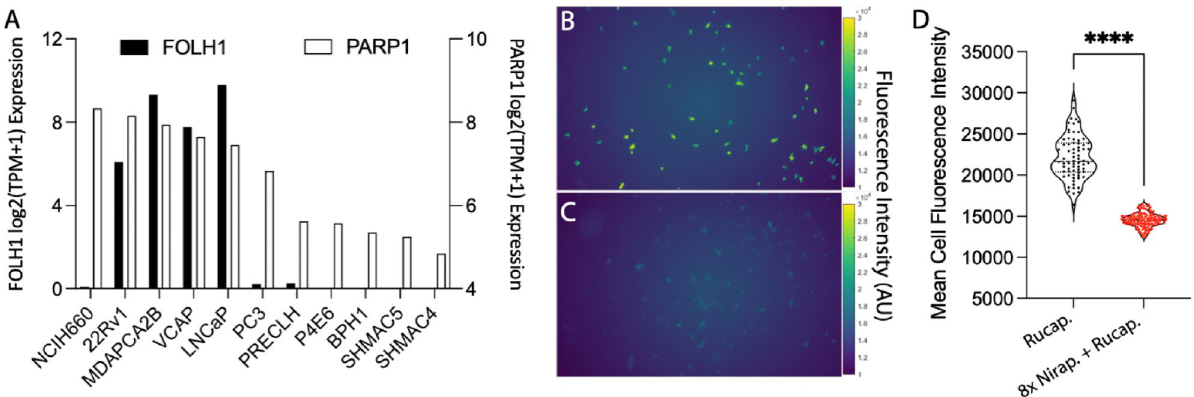
Figure 2. Cell Model Selection. ( A ) Evaluation of expression of FOLH1 and PARP1 in prostate and prostate cancer cell lines. ( B ) Fluorescence of rucaparib binding and uptake in 22Rv1 cells, ( C ) or blocked with